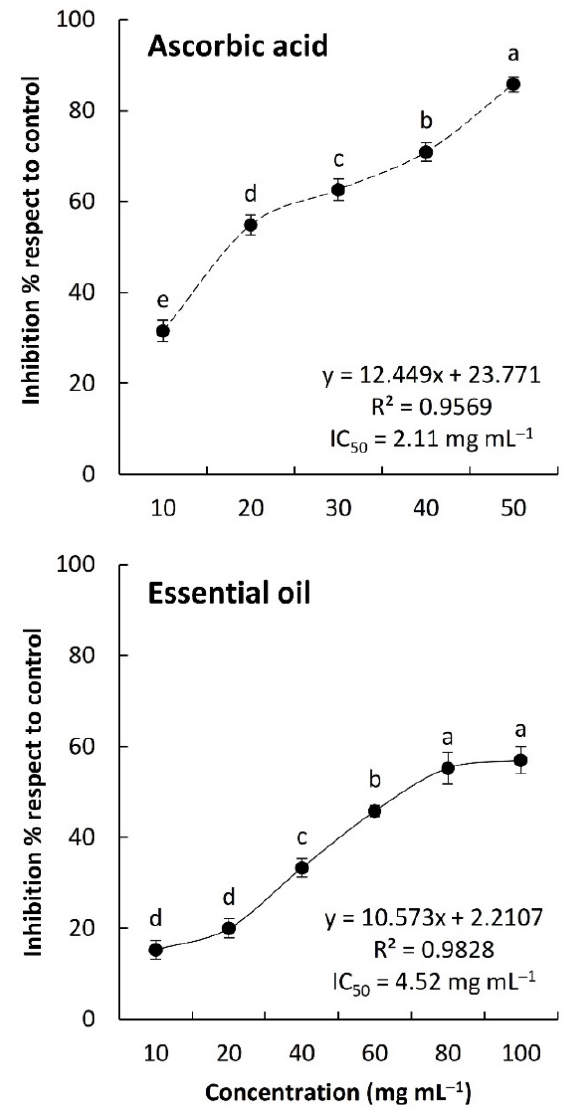
Figure 5. Antioxidant activity of the EO from the above-ground parts of Cleome amblyocarpa . Different letters of the line mean values significant at p < 0.05 (Tukey’s HSD test).